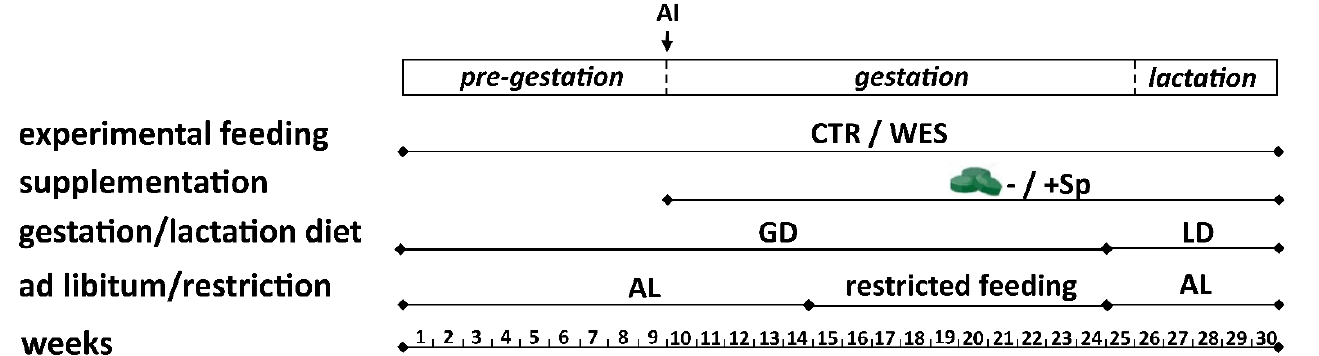
Figure 1. Schematic representation of the feeding experiment. AI: artificial insemination; AL: ad libitum; CTR: control diet; GD: gestation diet; LD: lactation diet; Sp: spirulina; WES: Western diet.